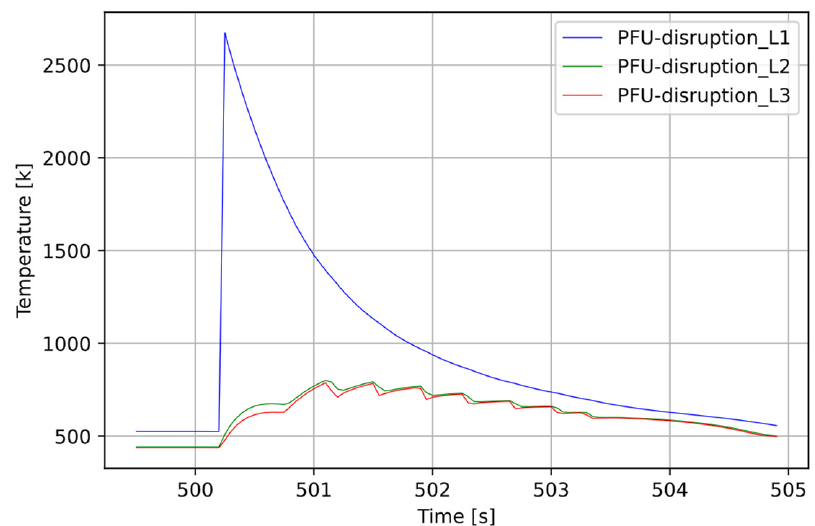
Figure 12. Temperature transient on HS impacted by disruption. Temperatures for W (L1), Cu (L2) and CuCrZr (L3) layers of the PFU vertical target HS are shown.